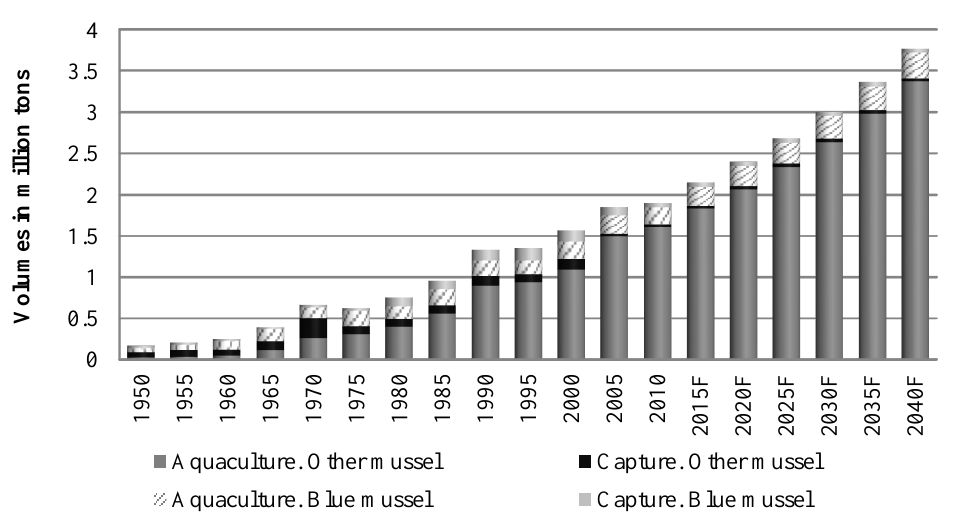
Fig. 5. Prognosis of volume of mussels, 1950‒2040 (FAO data, 2017; prognosis by the